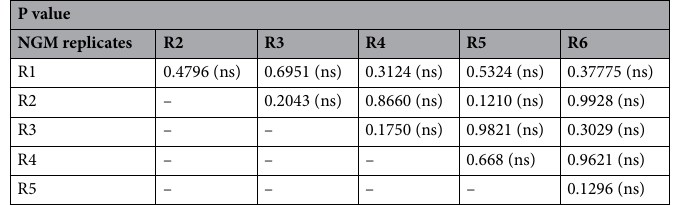
Table 2. p-values estimated in the comparison among replicates of NGM. A Log Rank t-test was applied. ns: without significant differences